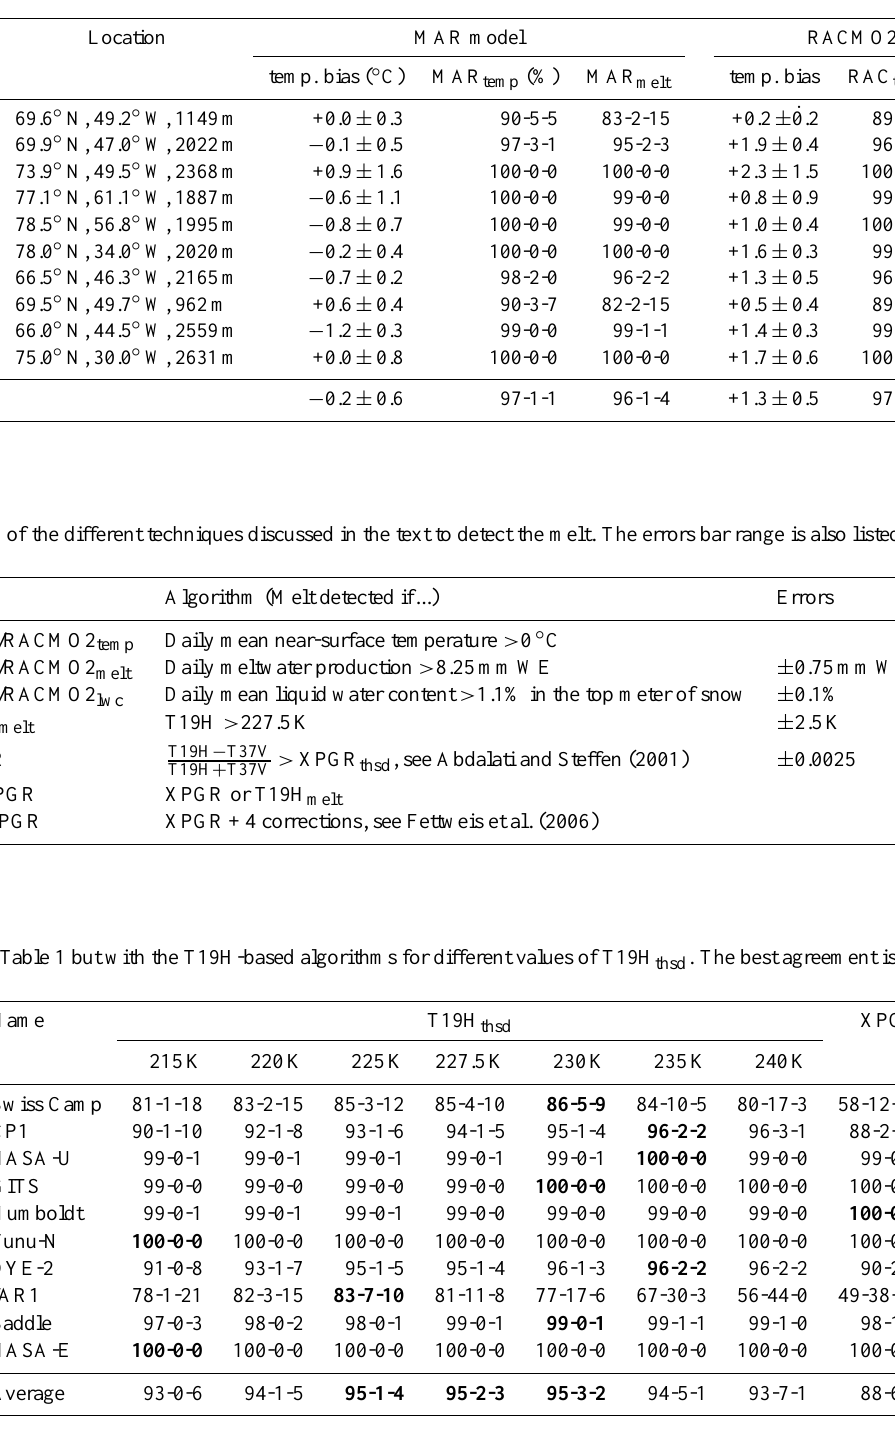
Table 1. Mean (over the 1995–2005 summers) percentage of number of melt days at 10GC-Net AWS’s (where melt is observed) when the RCM and the observations are in agreement, when the RCM fails to detect melt and when RCM detects melt while the observations do not. Two approaches, RCM-temp and RCM-melt (explained in Table 2), are used for detecting melt in the RCM modeled time series. The location of the GC-Net AWS’s is also listed. Finally, the mean modeled daily temperature bias (in ◦ C) with respect to the GC-net measurements over the 1995–2005 summers is also given.